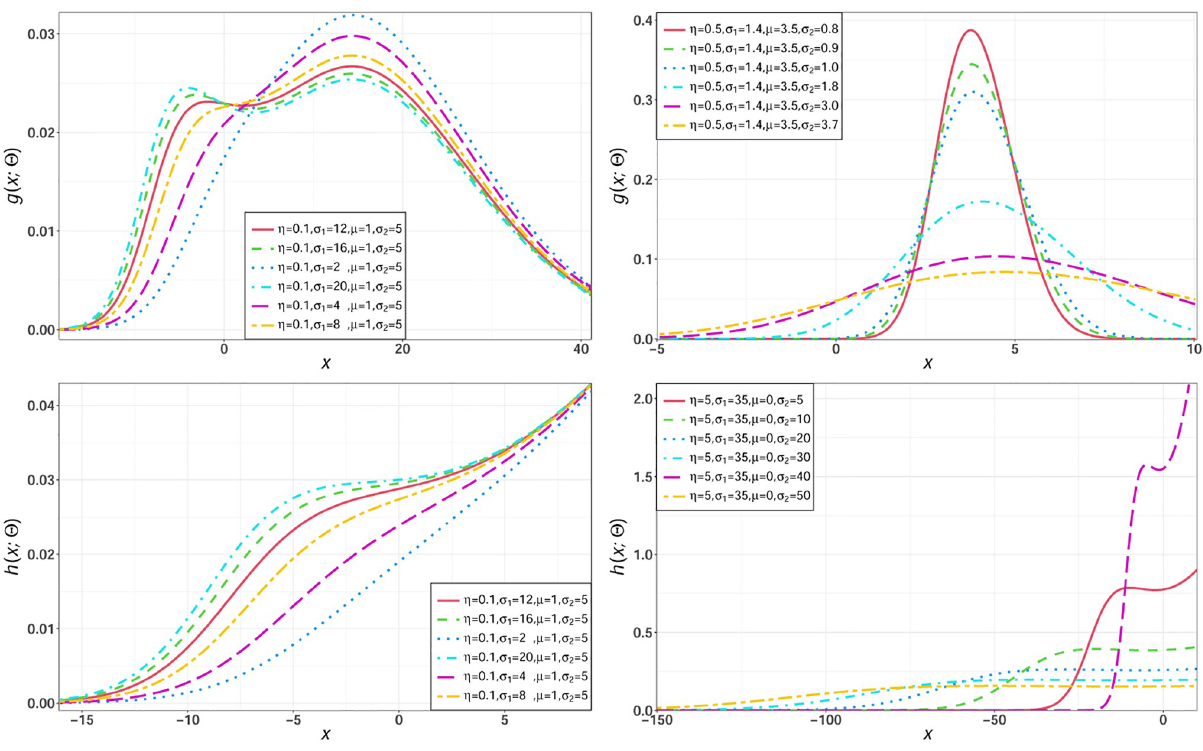
Fig 2. Different shapes for the pdf and hrf of the NEHTN